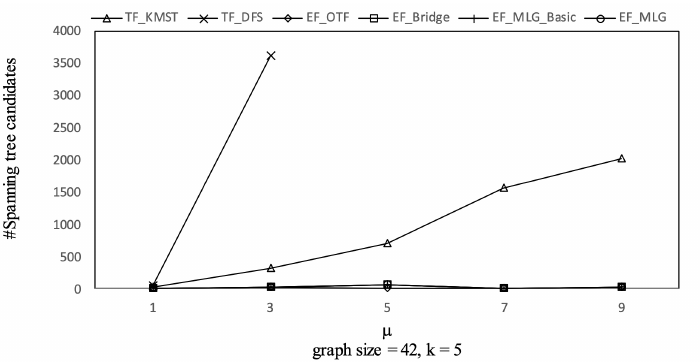
Figure 22. Spanning tree pruning on GraphGen vs. µ with graphsize = 42 and k = 5.